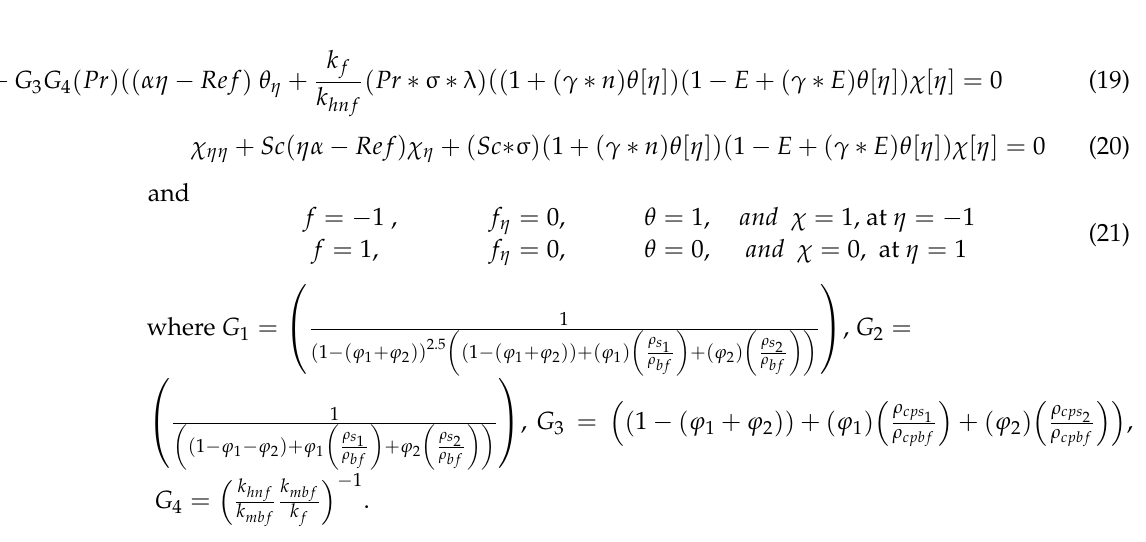
Table 1. Thermophysical features of a hybrid nanofluid and NPs [41]. Physical Properties